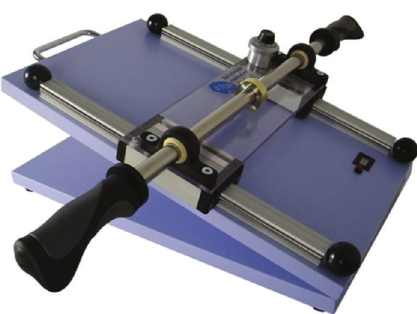
Figure 5: The Rocker for APBT. Reprinted with